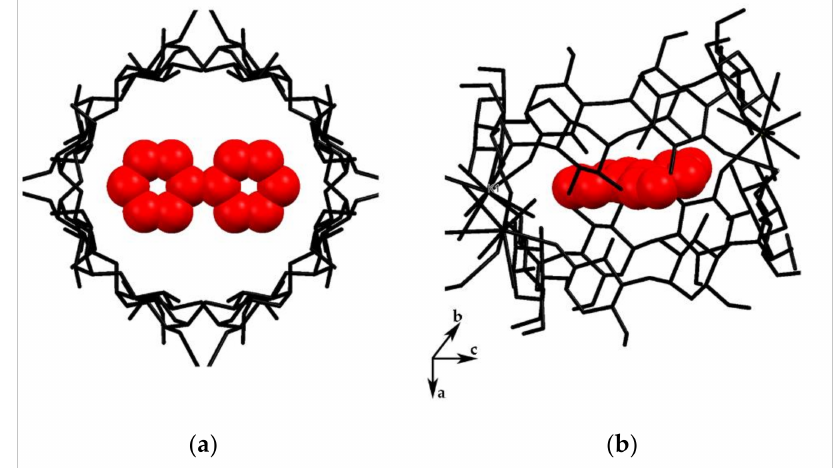
Figure 7. ( a ) Arrangement of γ -CD and toluene molecules in ε · tol-phase along a -axis. ( b ) Arrangement of toluene molecules between two γ -CD rings leading to sandwich-type